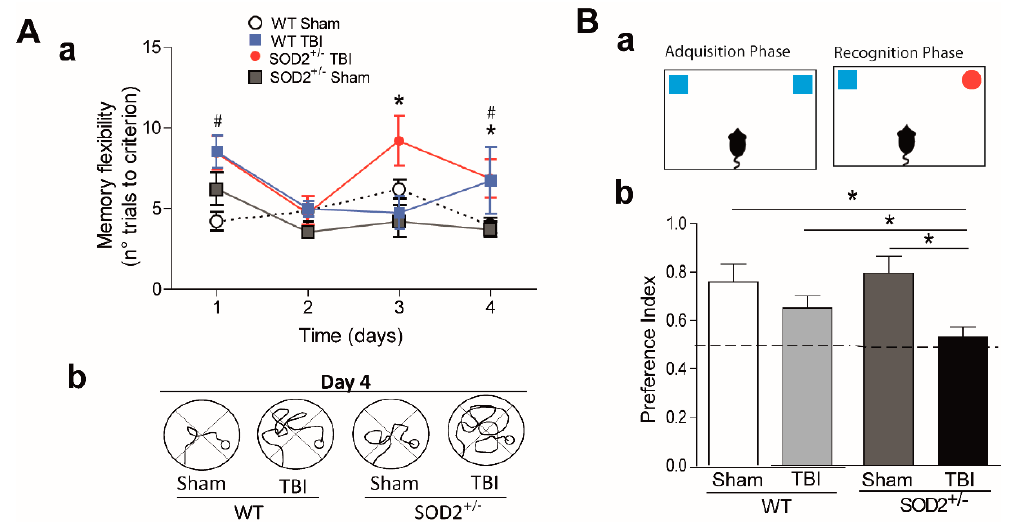
Figure 2. WT and SOD2 +/- mice show cognitive impairment after TBI. A. Behavioral performance was evaluated by the memory flexibility test ( A ), and NOR test ( B ). Spatial memory of WT and SOD2 +/- mice after TBI was evaluated by the memory flexibility test (Aa). (Ab) Representative swimming trajectories for WT and SOD2 +/- mice of different conditions on day 4. An increase in the number of trials necessary to reach the criterion is observed in WT and SOD2 +/- sham animals versus WT and SOD2 +/- TBI animals. B. TBI induces impairment performance in the NOR test in SOD2 +/- mice. 6 animals were used per experimental group. Data are means ± S.E. Statistically significant differences were calculated by one-way or two-way ANOVA and, followed by Bonferroni’s post hoc test. (Figure 2A: # p ˂ 0.5; between WT Sham and WT TBI; * p ˂ 0.5; between SOD2 +/- Sham and SOD2 +/- TBI; Figure 2B: * p ˂ 0.5; NOR, novel object recognition).